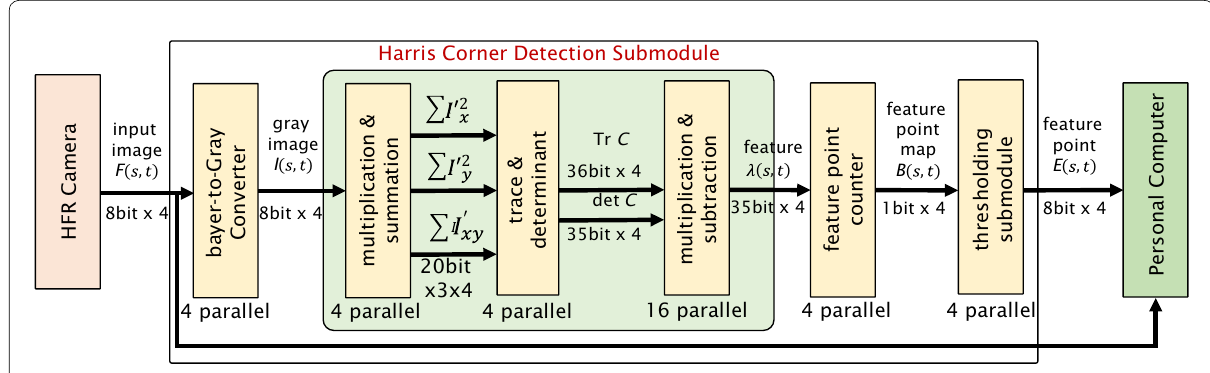
Fig. 3 Hardware circuit module for Harris corner feature extraction